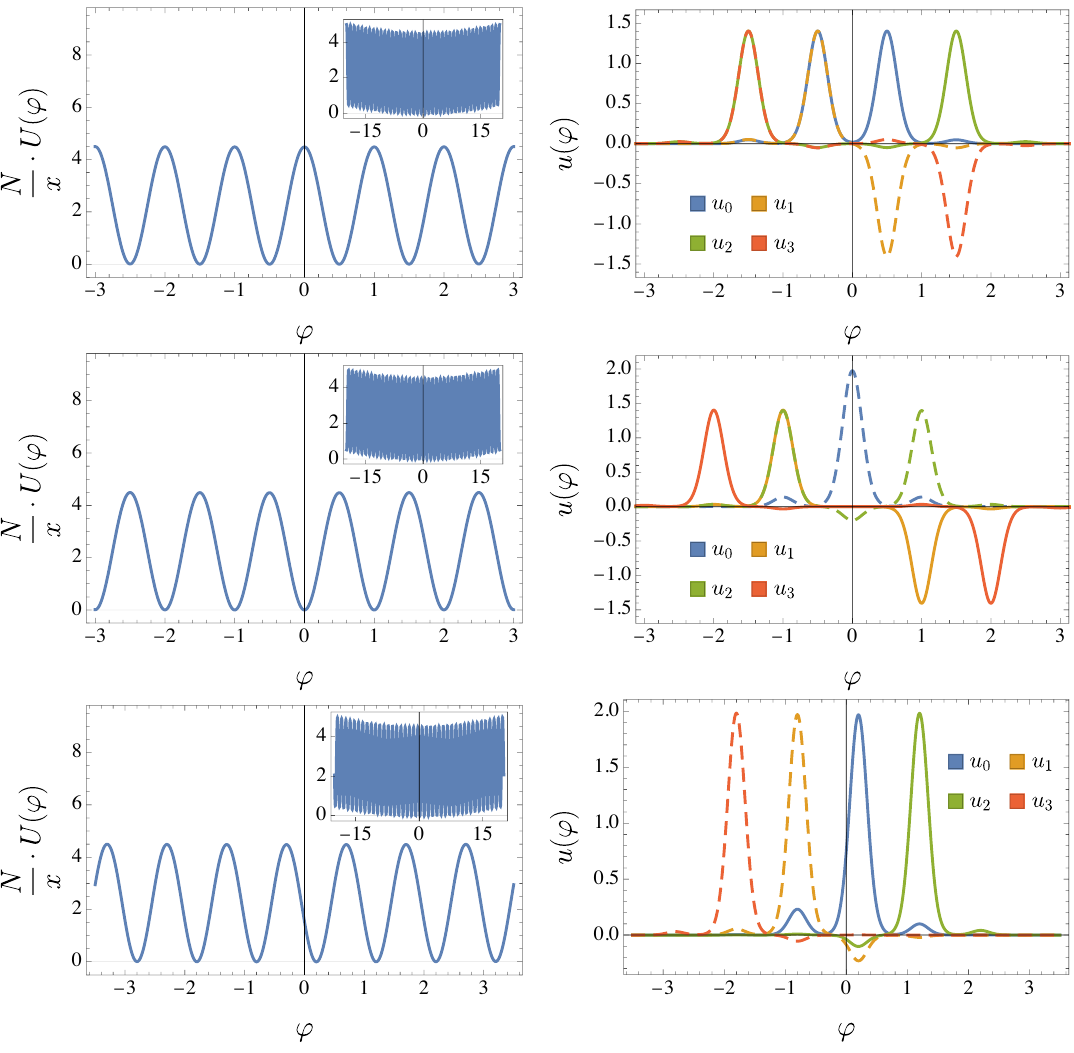
Figure 8. The (dimensionless) effective quantum mechanical potential in (4.6) and the (dimension- less) wavefunctions of the lowest four Hamiltonian eigenstates for m/g = 50 , mL = 8 , a double-well regime example, on N = 10 lattice. Upper panel: α = 0 . 5 , middle panel: α = 0 , lower panel: α = 0 . 2 . The wavefunctions u 0 , u 1 , u 2 , u 3 are respectively the ones in ϕ -representation for the ground, the first-, the second-, and the third-excited